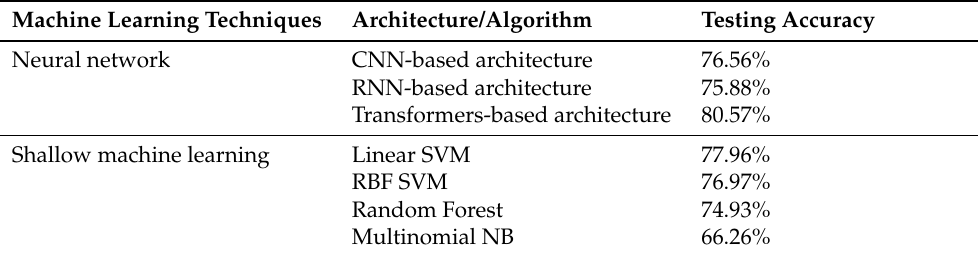
Table 6. Comparison between the neural network and shallow machine learning techniques on the SNS24 clinical triage classification